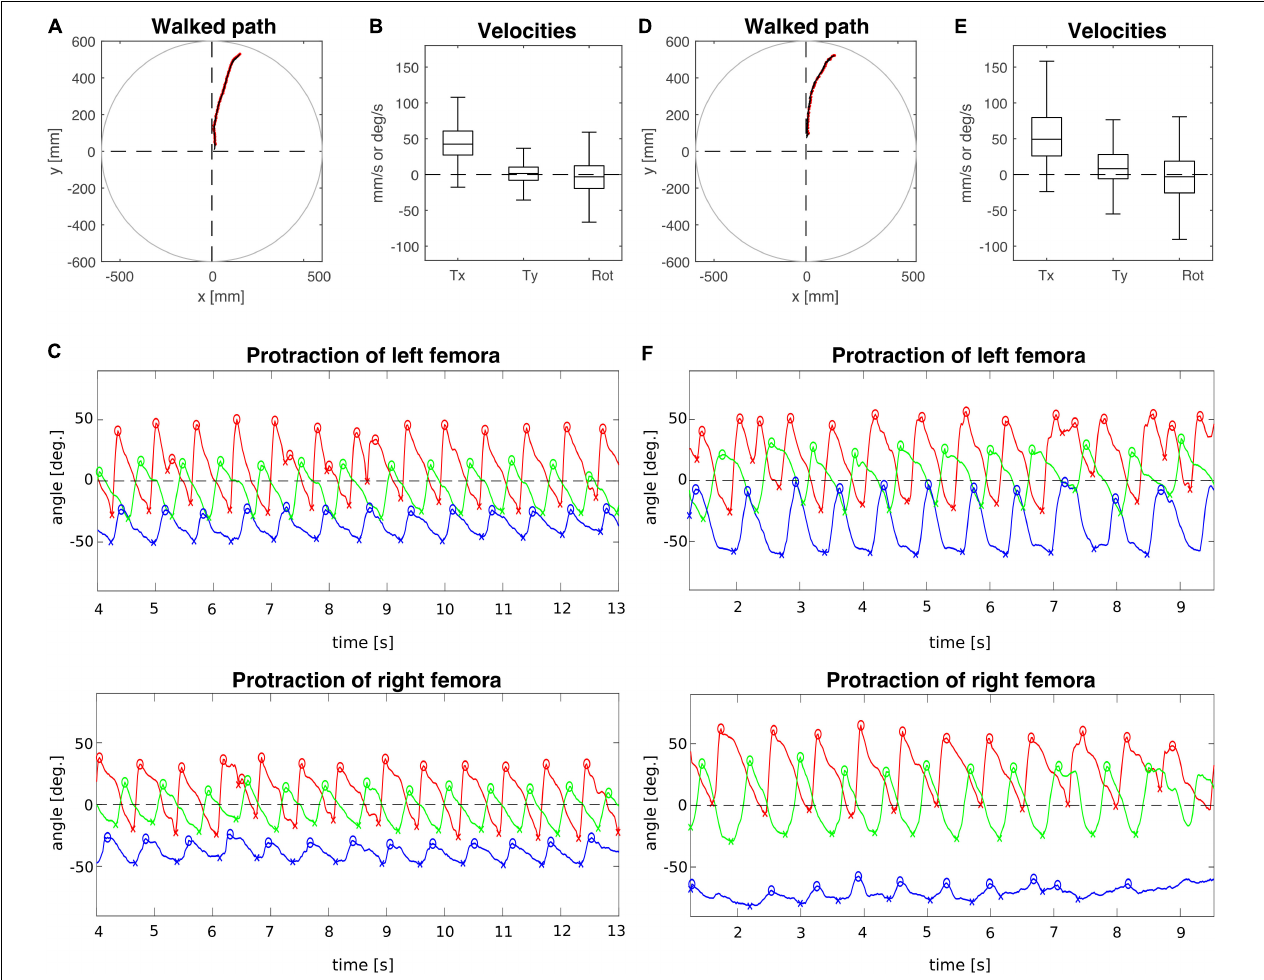
FIGURE 3 | Representative trials of two animals that had undergone an operation at the meso-to-metathorax connective. (A–C) T3 sham operation; (D–F) T3 connective lesion. Same graphics details as in Figures 2 A,D : Walked path of the animal in the circular arena. Here, the animals started to walk in cardinal direction 90 ◦ (see Figure 1C ) and turned toward the border of a visual landmark on the arena rim at 60 deg. (B,E) Fluctuation of forward (T x ) and sideward (T y ) translational velocities (in mm/s) as well as the rotational velocity about the yaw axis (in deg/s). (C,F) Time courses of protraction/retraction angles of the animals’ front (red), middle (green) and hind legs (blue). Zero degrees (black dashed lines) corresponds to a leg posture orthogonal to the body axis. The anterior and posterior extreme positions are marked by circles and crosses. Note that the time course of the trial shown in (C) was truncated to the same time window as the trial shown in (F) . The complete trial is shown in Supplementary Figure 3